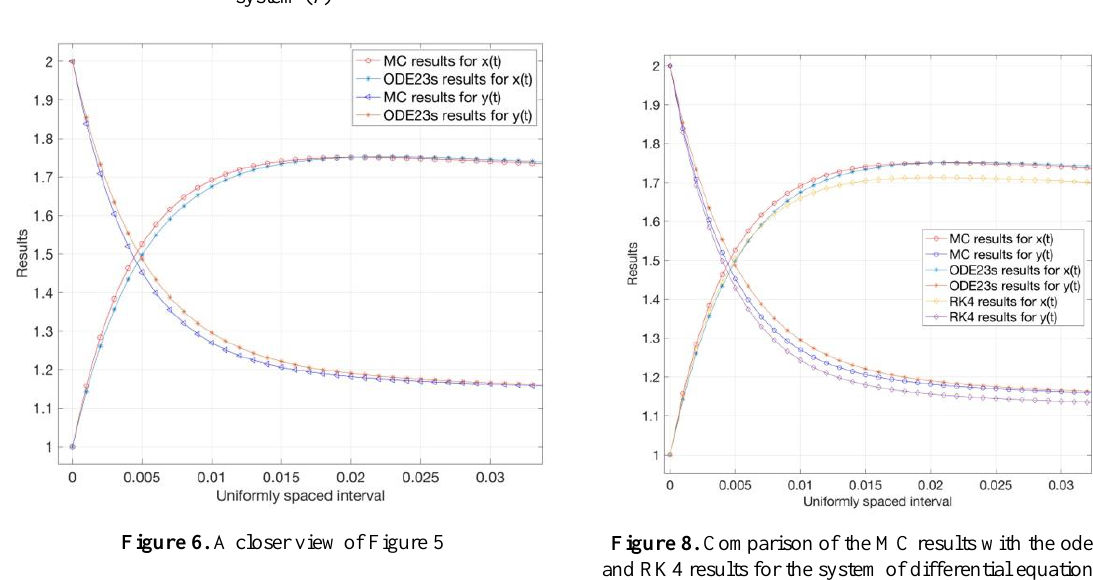
Figure 5. Comparison of the MC prediction results and the Figure 7. Differences between the MC prediction results ode23s results of the first order stiff differential equation and the ode23s results of Equation (7) system (7)